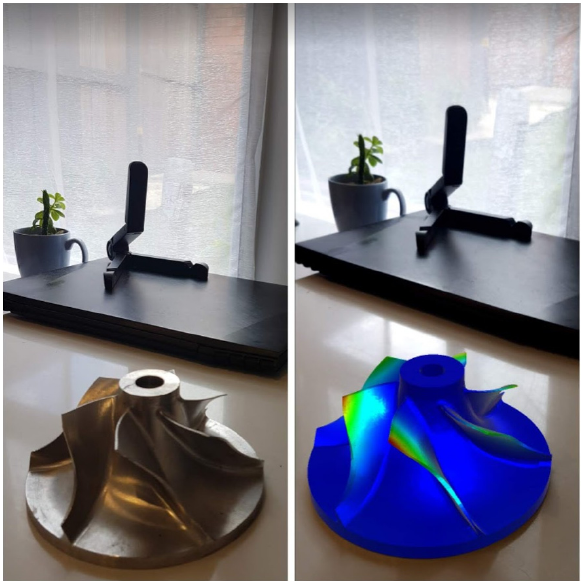
Figure 9. Product real view and AR visualization in a real environment.